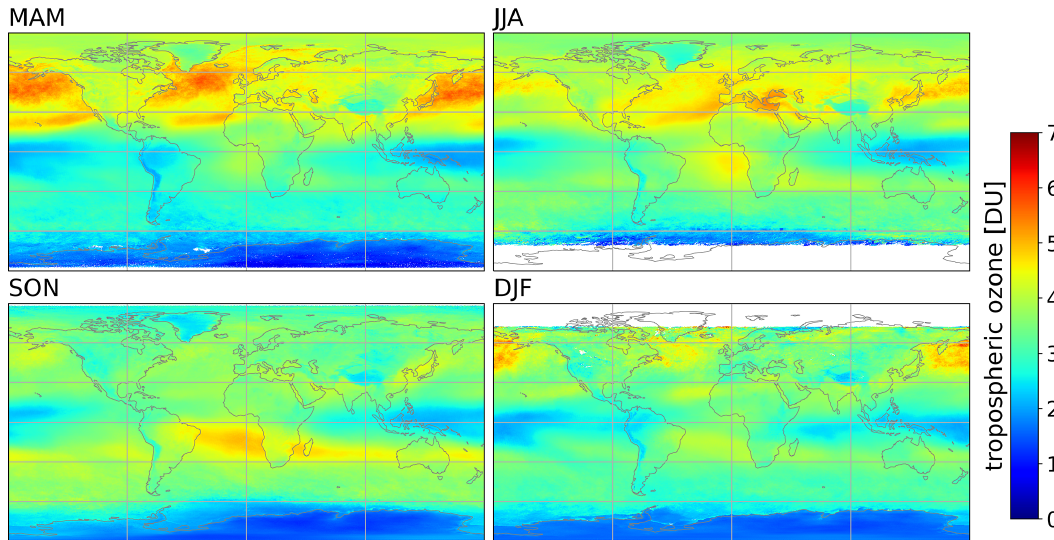
Figure 11. Global distribution of the mean tropospheric ozone for the four seasons obtained from S5P-BASCOE between 2018 and